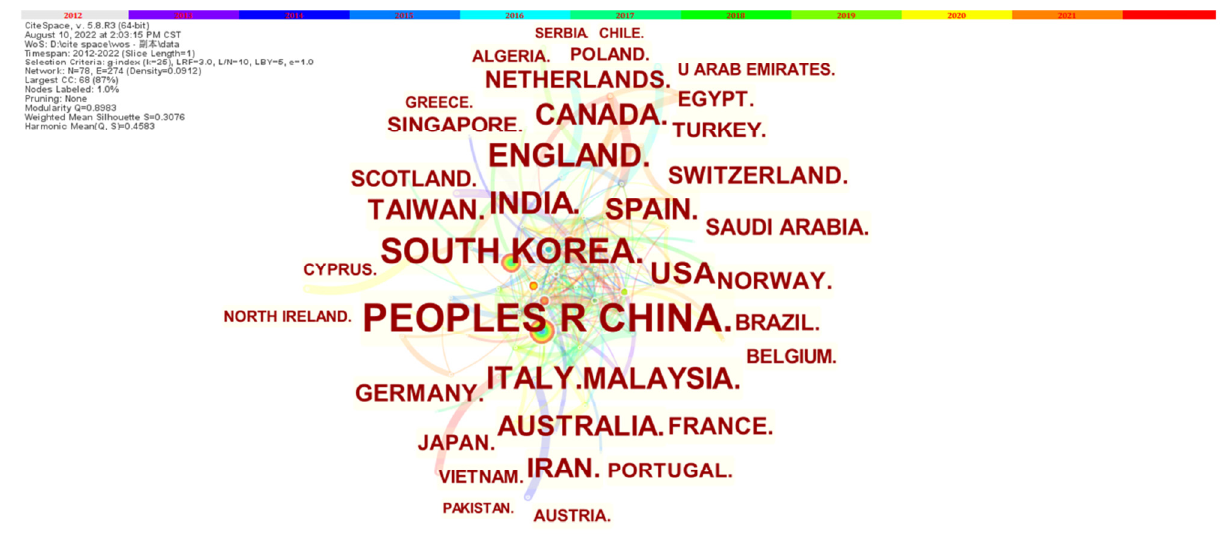
Figure 4. National cooperation network diagram. Table 6. The top 15 countries by centrality.